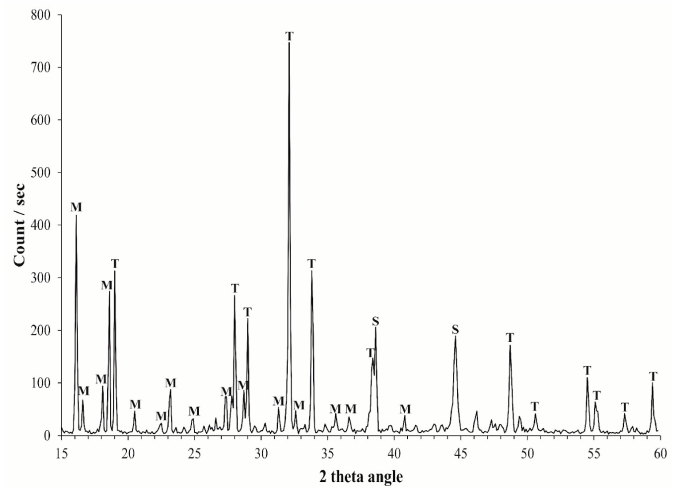
Figure 3. X-ray powder diffractograms of salt crystals. M: mirabilite; T: thenardite; S: sample